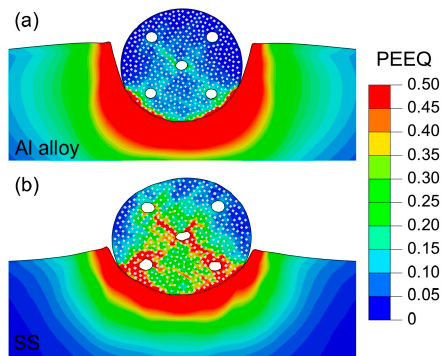
Figure 6. PEEQ distribution within a WC-Co particle after impact onto ( a ) Al alloy and ( b ) SS substrates.